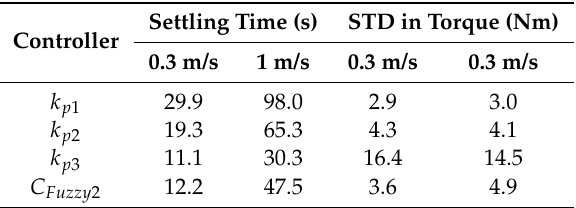
Table 2. Comparison of the settling time and noise in the torque using the fuzzy controller and proportional controllers.